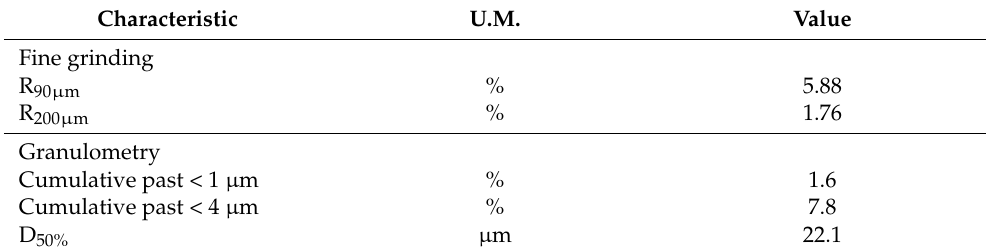
Table 5. The main characteristics of the ground coke oil + coal mixture. Characteristic U.M.